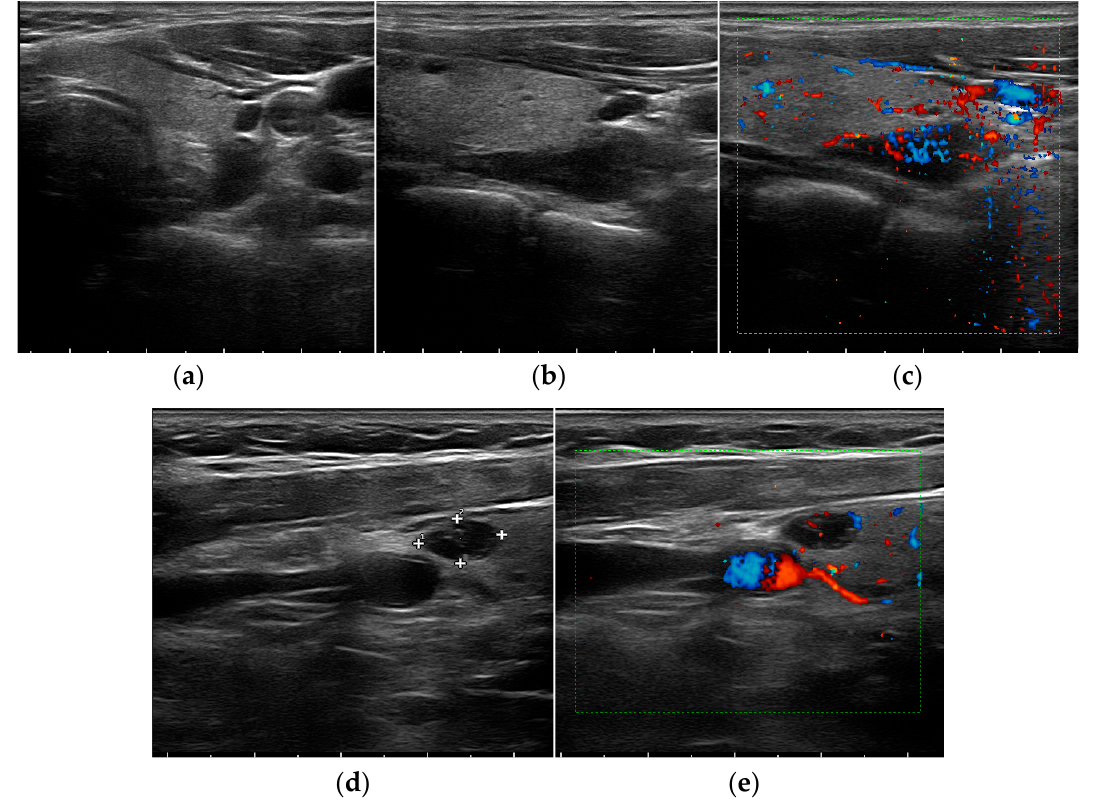
Figure 1. Grey-scale ( a , b , d ) and Color Doppler ( c , e ) aspect of a parathyroid adenoma.